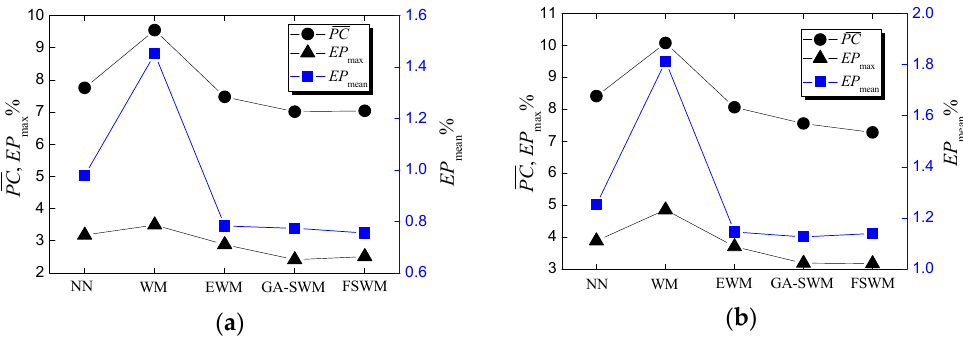
Figure 6. Comparisons of five Wiener models using the average performance indices: ( a ) Train mode; ( b ) Test mode.